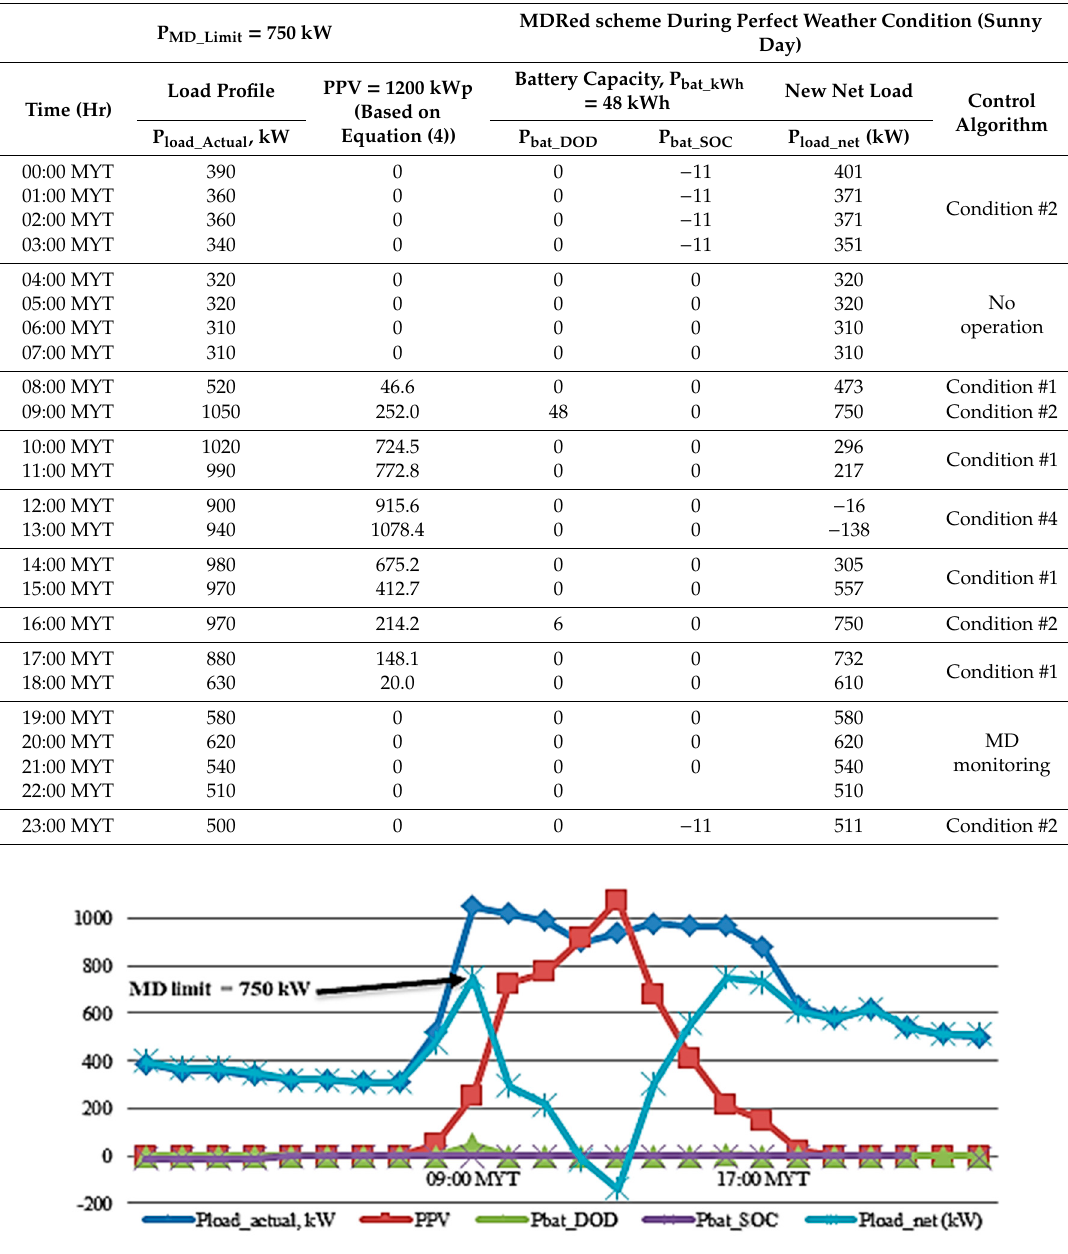
Table 10. MDRed model validation data with solar PV-battery system.